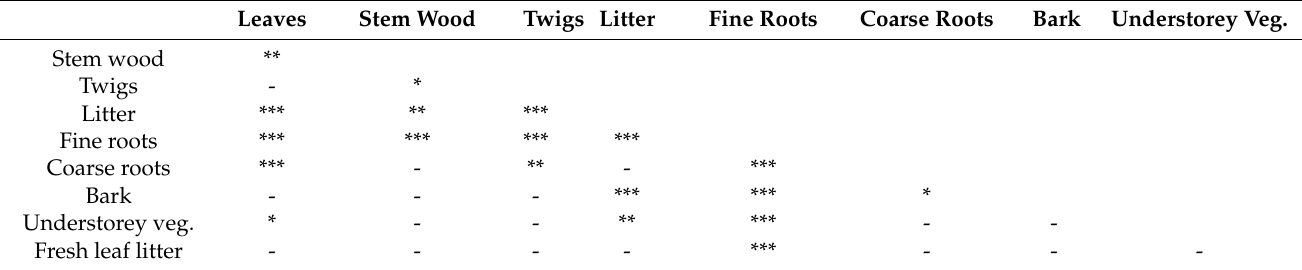
Table 4. Significance level matrix of components. *** = high significance ( p ≤ 0.005), ** = medium significance